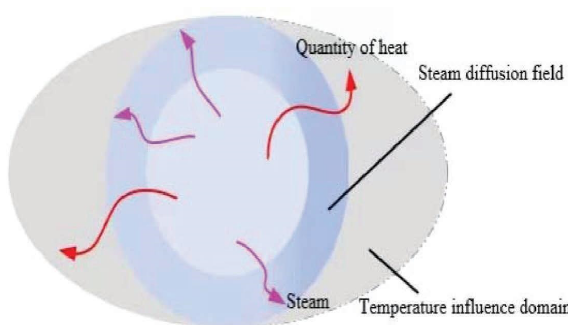
Figure 12: Teoretical droplet evaporation